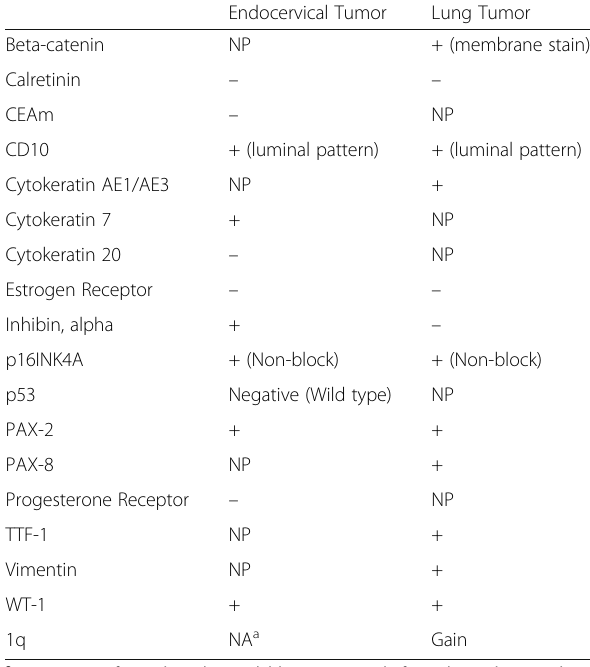
Table 3 Immunohistochemical and in situ hybridization for both the primary and the metastatic tumors Endocervical